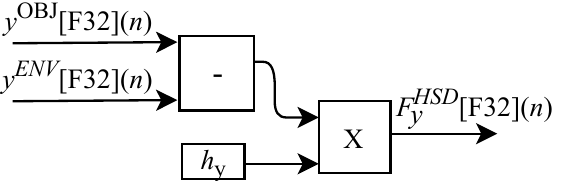
Figure 30. Proposed circuit to calculate the feedback force F HSD y [ F 32 ]( n ) (Equation (61))—FBF-HSD.